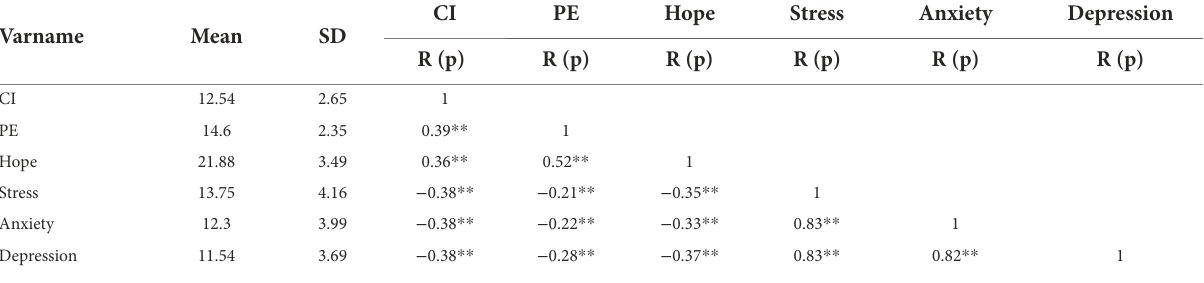
TABLE 2 Correlation between model variables ( n = 635).